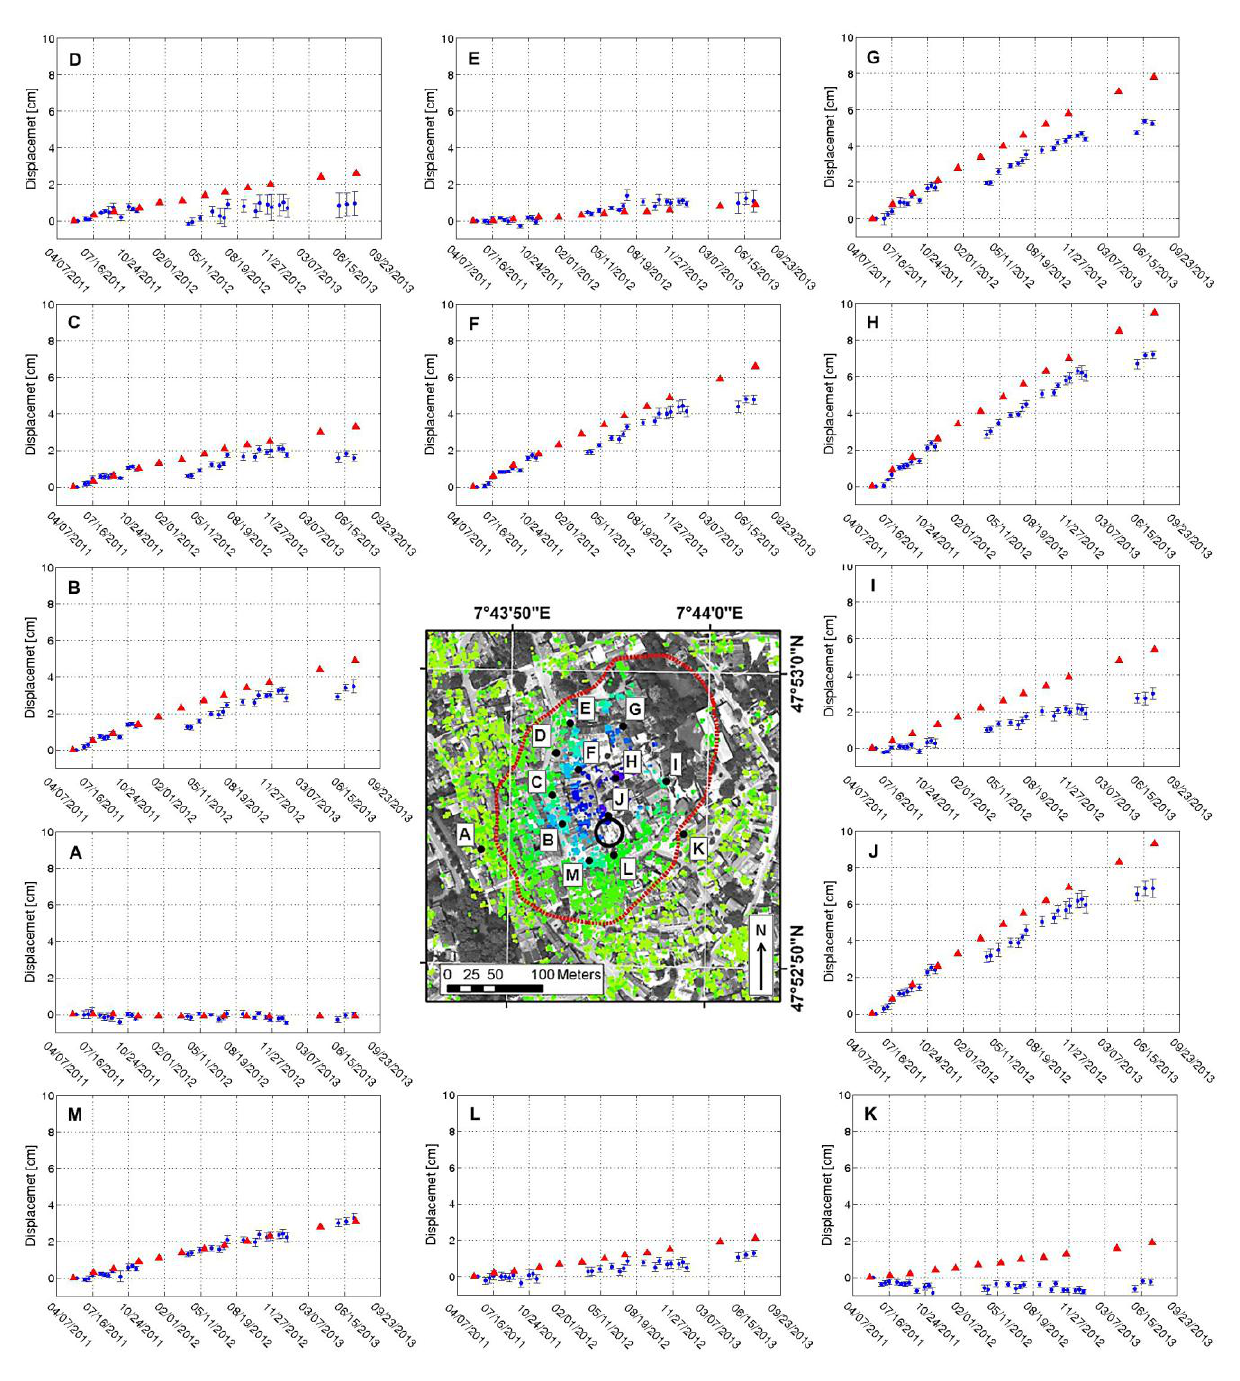
Figure 6. Time series of displacements at selected locations. Red triangles correspond to leveling measurement and blue dots with error bars to Small BAseline Subsets (SBAS) results using the ascending data from 2011–2013 time period. The locations are highlighted as black dots in the centered image (enlarged subset of the displacement field of Figure